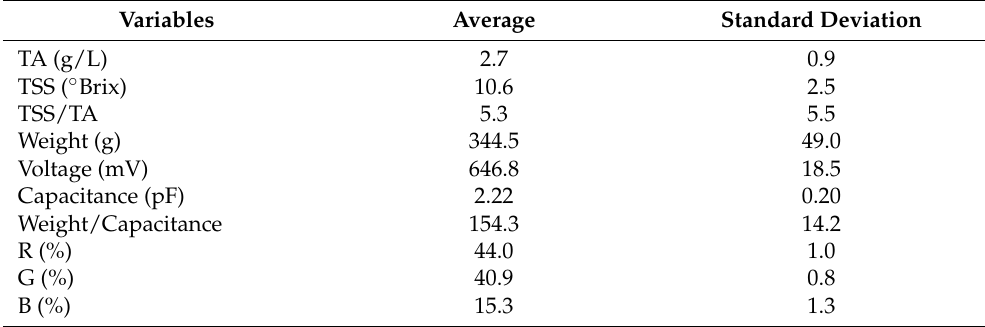
Table 3. The average and standard deviation for biochemical, physical, and electrical properties of 100 mango samples.